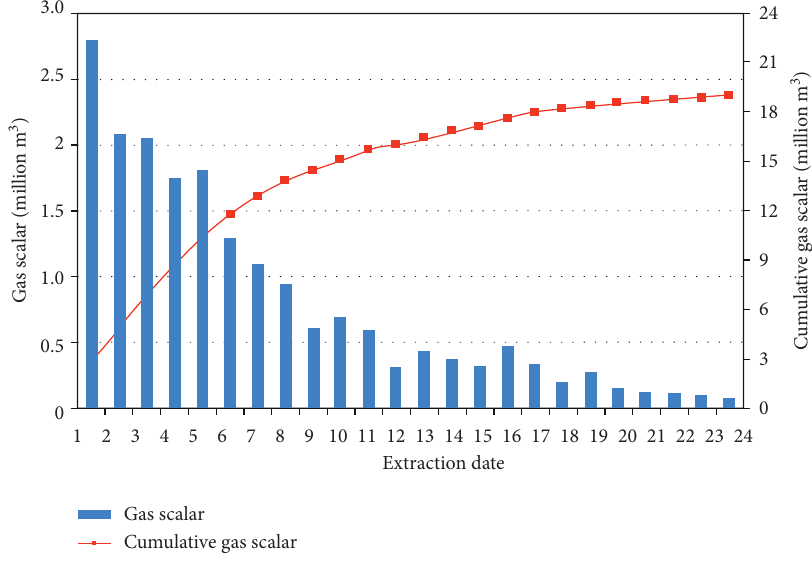
Figure 12: Gas extraction purity and cumulative extraction purity of borehole No. 1-3.